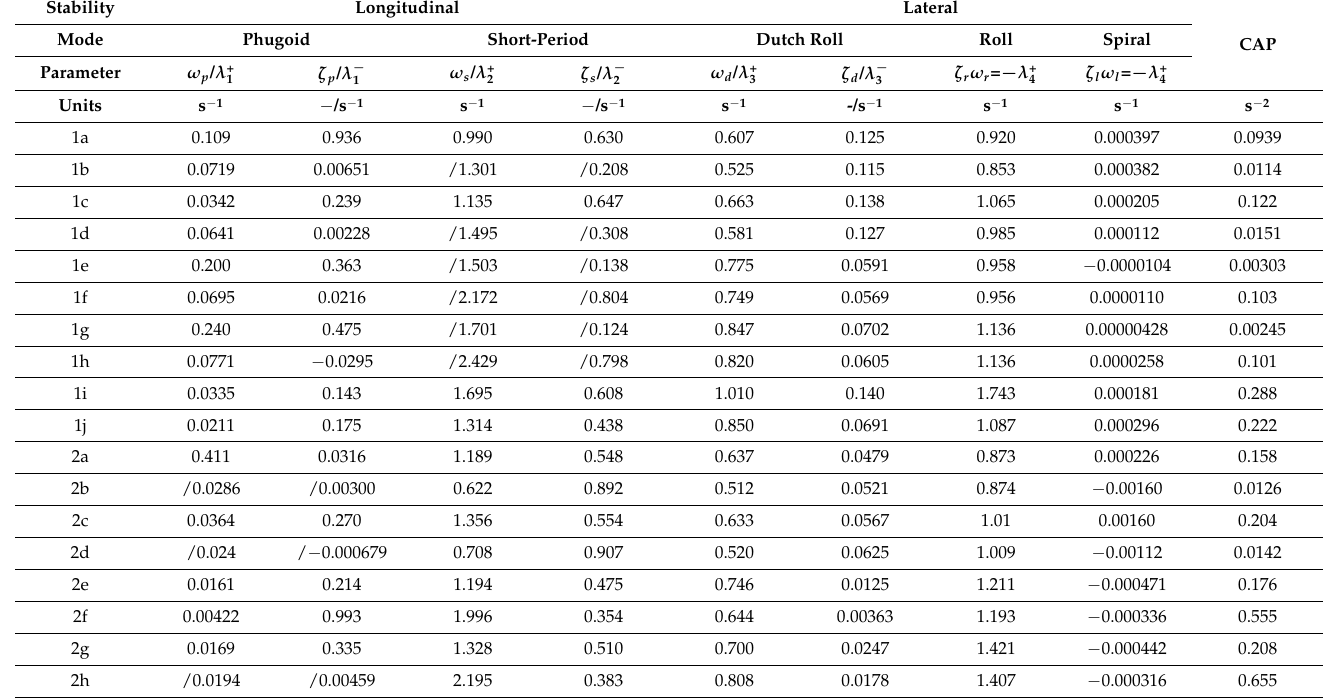
Table 9. Parameters of flight modes: λ ± –eigenvalues; ω –natural frequency; ζ –damping ratio; CAP = control anticipant parameter. Stability